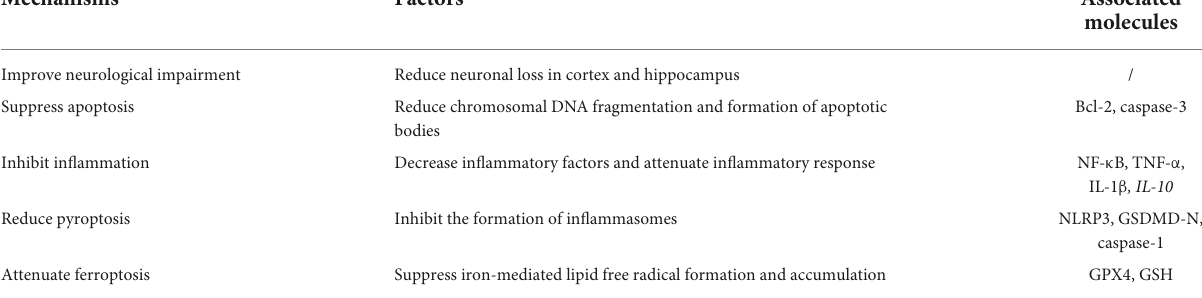
TABLE 1 Functions of m6A modification in CNS